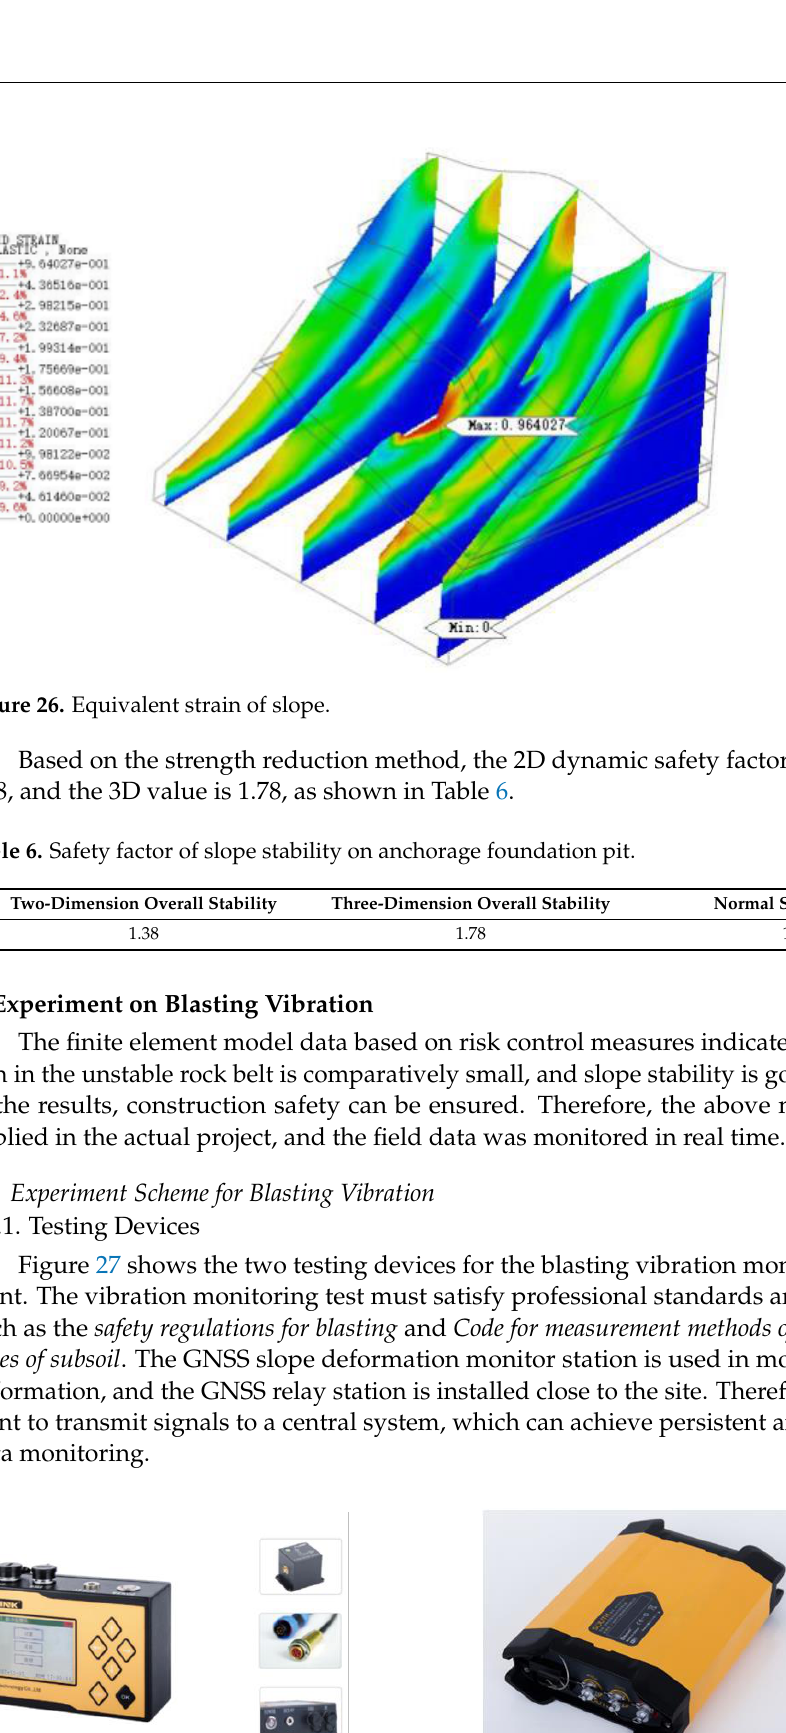
Figure 27. Testing devices: ( a ) Vibration monitor; ( b ) Slope deformation monitor.